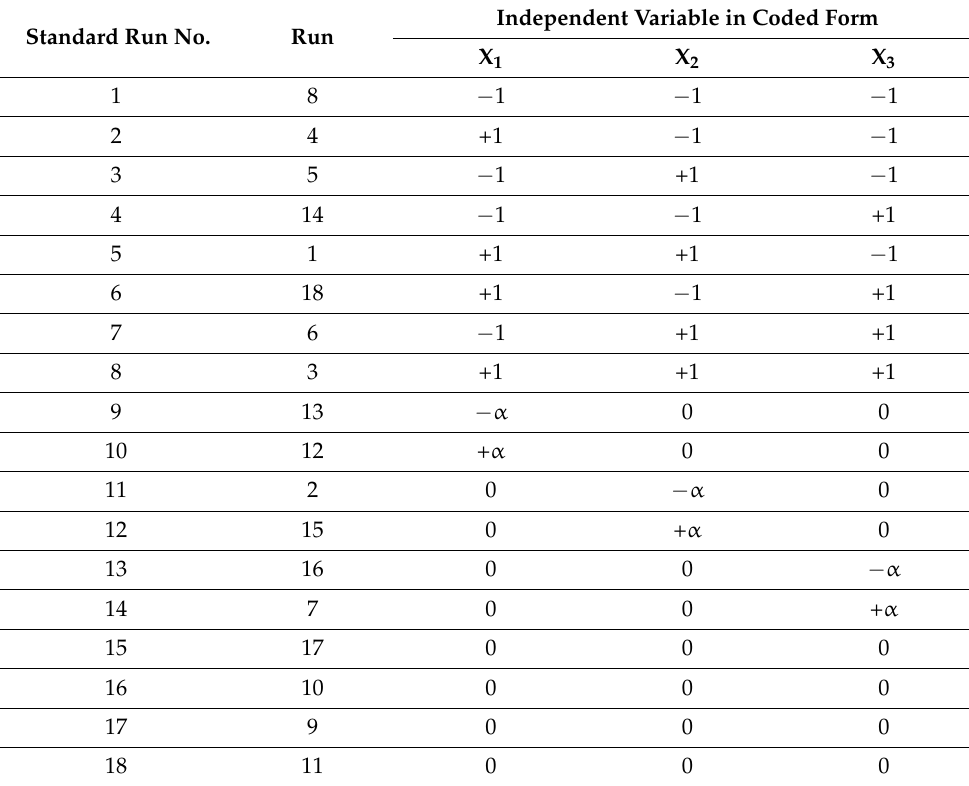
Table 2. Experimental runs in coded units using central composite design RSM. Independent Variable in Coded Form Standard Run No. Run X 1 X 2 X